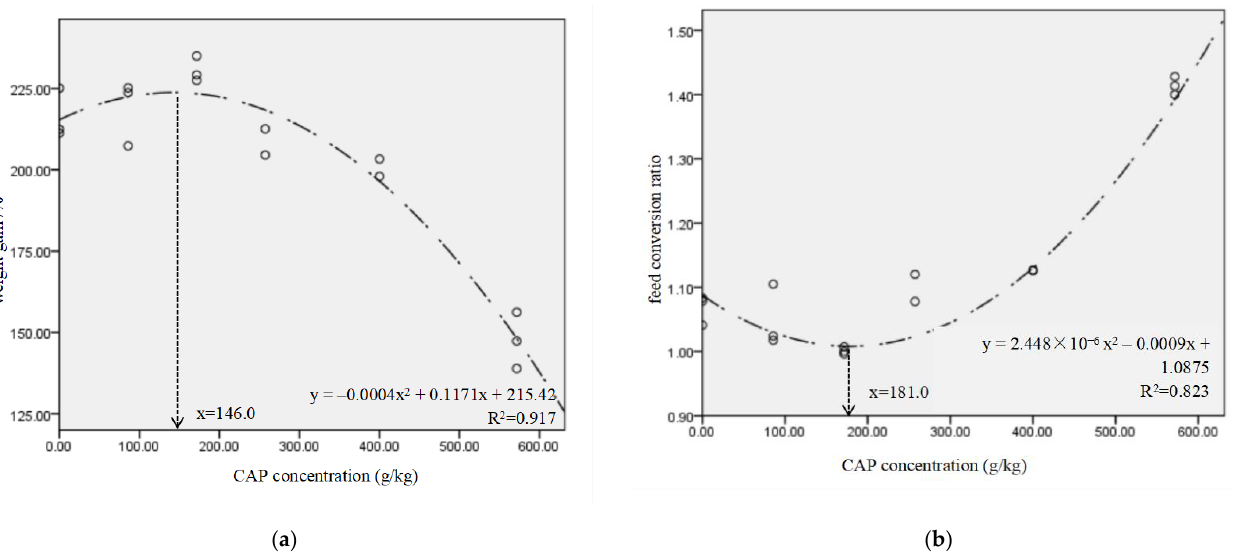
Figure 2. Relationship between CAP addition level and weight gain ( a )/feed conversion ratio ( b ) for largemouth bass. Data are fitted with a nonlinear regression model (binomial regression model). Table 4. Effects of dietary Clostridium autoethanogenum protein on growth and body index of large- mouth bass.